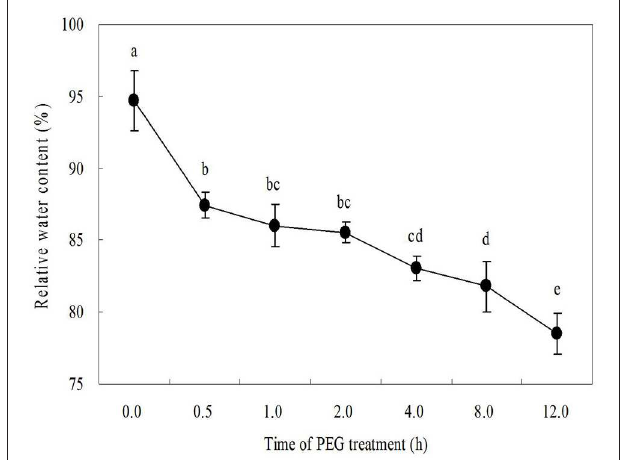
FIGURE 1 | Time course of PEG 6000-induced the change of leaf relative water content (%) as an indicator of water deficit. The detached leaves were pre-treated with distilled water for 1h to eliminate wound stress and then exposed to 15% PEG solution for 12h. Means of six independent samples are presented. Bars represent standard errors. The same letter indicates no significant difference (LSD) at P < 0.05.